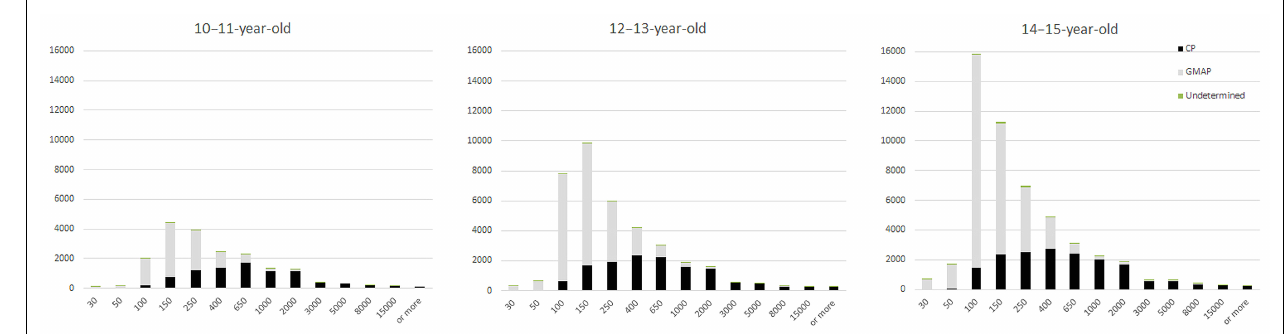
FIGURE 5 | Pause types identified in 10–11-year-old, 12–13-year-old, and 14–15-year-old texts.